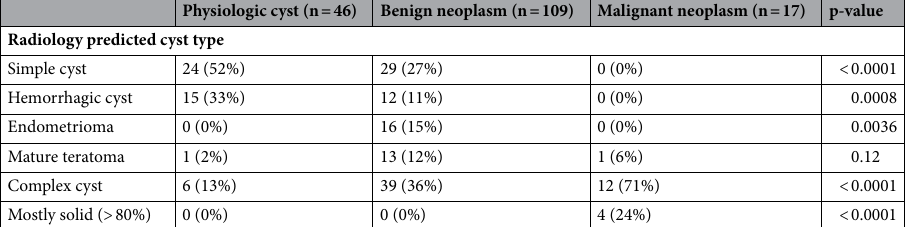
Table 4. Sonographic prediction of adnexal mass compared to final pathology. Masses were classified as simple cyst, hemorrhagic cyst, endometrioma, dermoid, complex cyst and mostly solid. Complex cysts were defined as masses with cystic as well as internal solid components that made up < 80% of the mass volume. Masses with > 80% solid components and no characteristic findings of dermoid were classified as “mostly solid.” All four of the masses classified as “mostly solid” on preoperative imaging were malignant. P-values were calculated by Fisher’s exact test to compare three